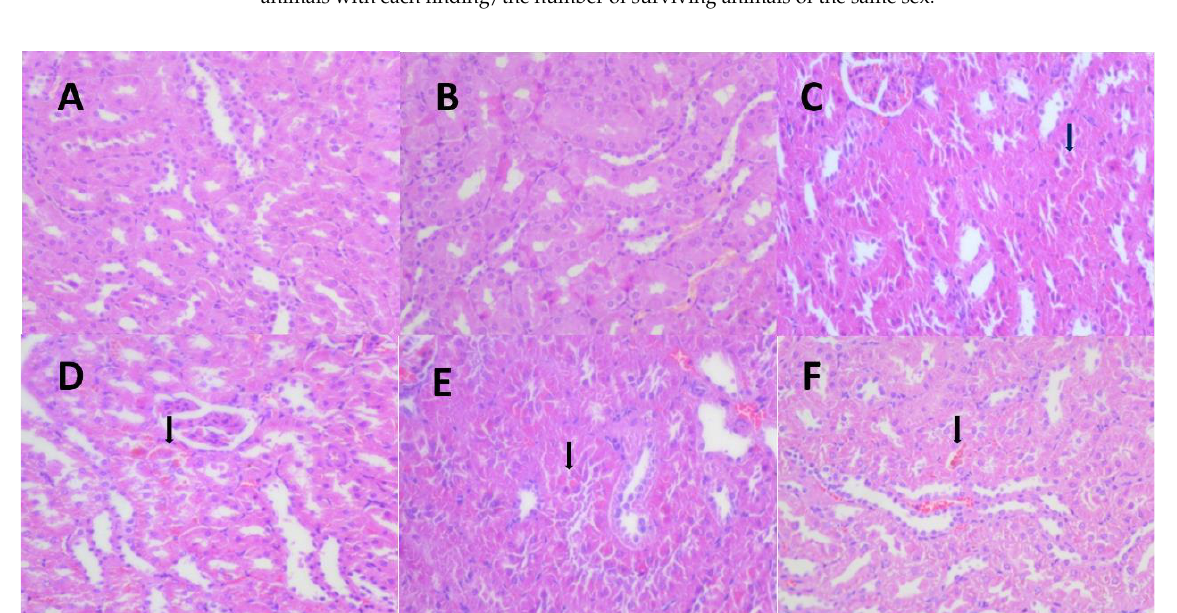
animals with each finding/the number of surviving animals of the same sex.